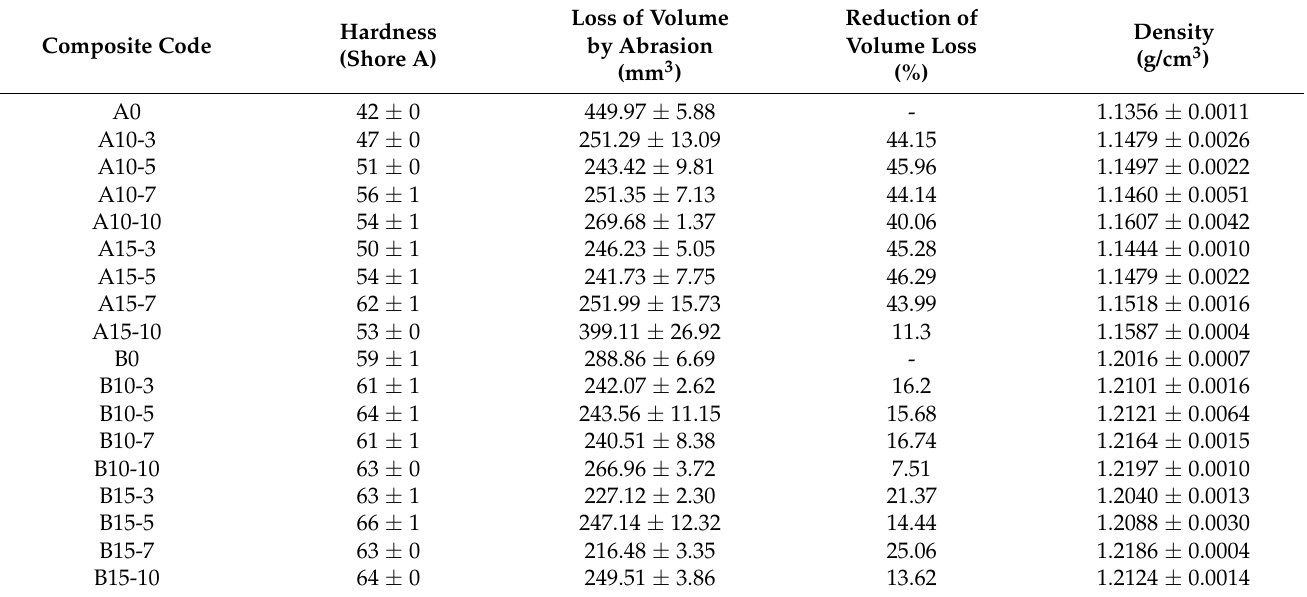
Table 4. Physical properties of rubber nanocomposites and loss of material by